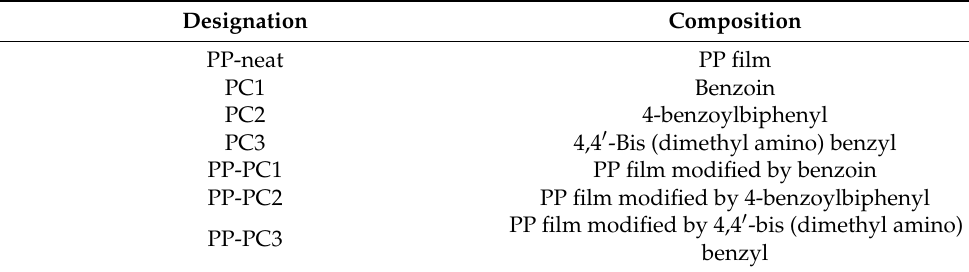
Figure 1. Molecular structures of the three kinds of polycyclic compounds. Table 1. Designation and composition.